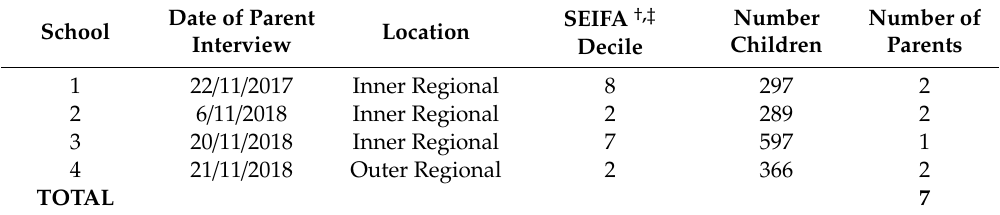
Table 1. School Demographics and